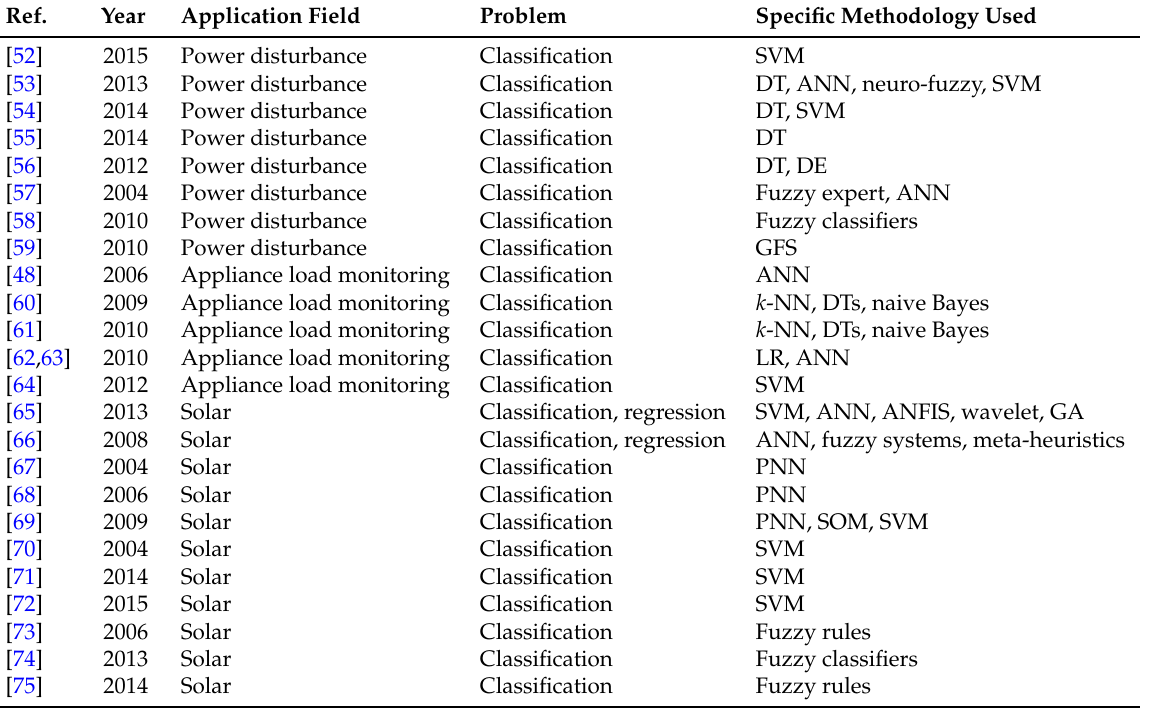
Table 3. Summary of the main references analyzed, grouped by application field, problem type and methodologies considered (II).